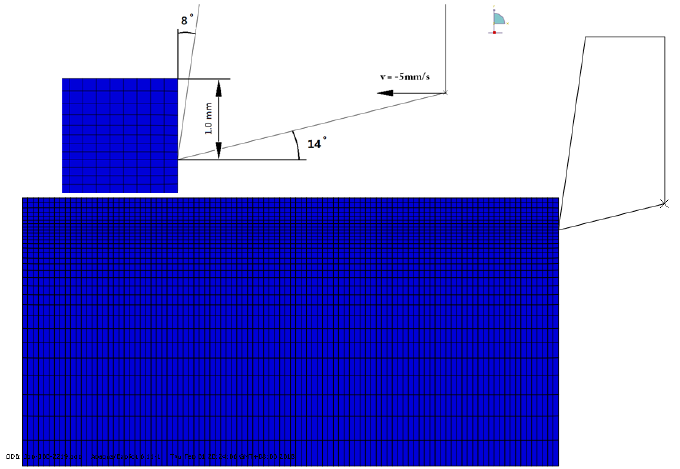
Figure 10. Finite element simulation results of the FE model of the tool–workpiece pair.